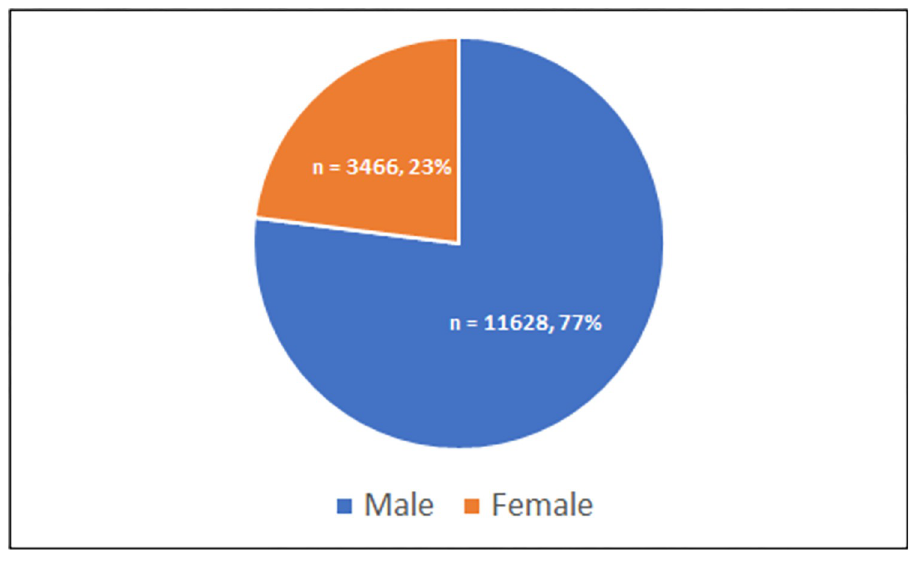
Fig 2. Participant details (sex).